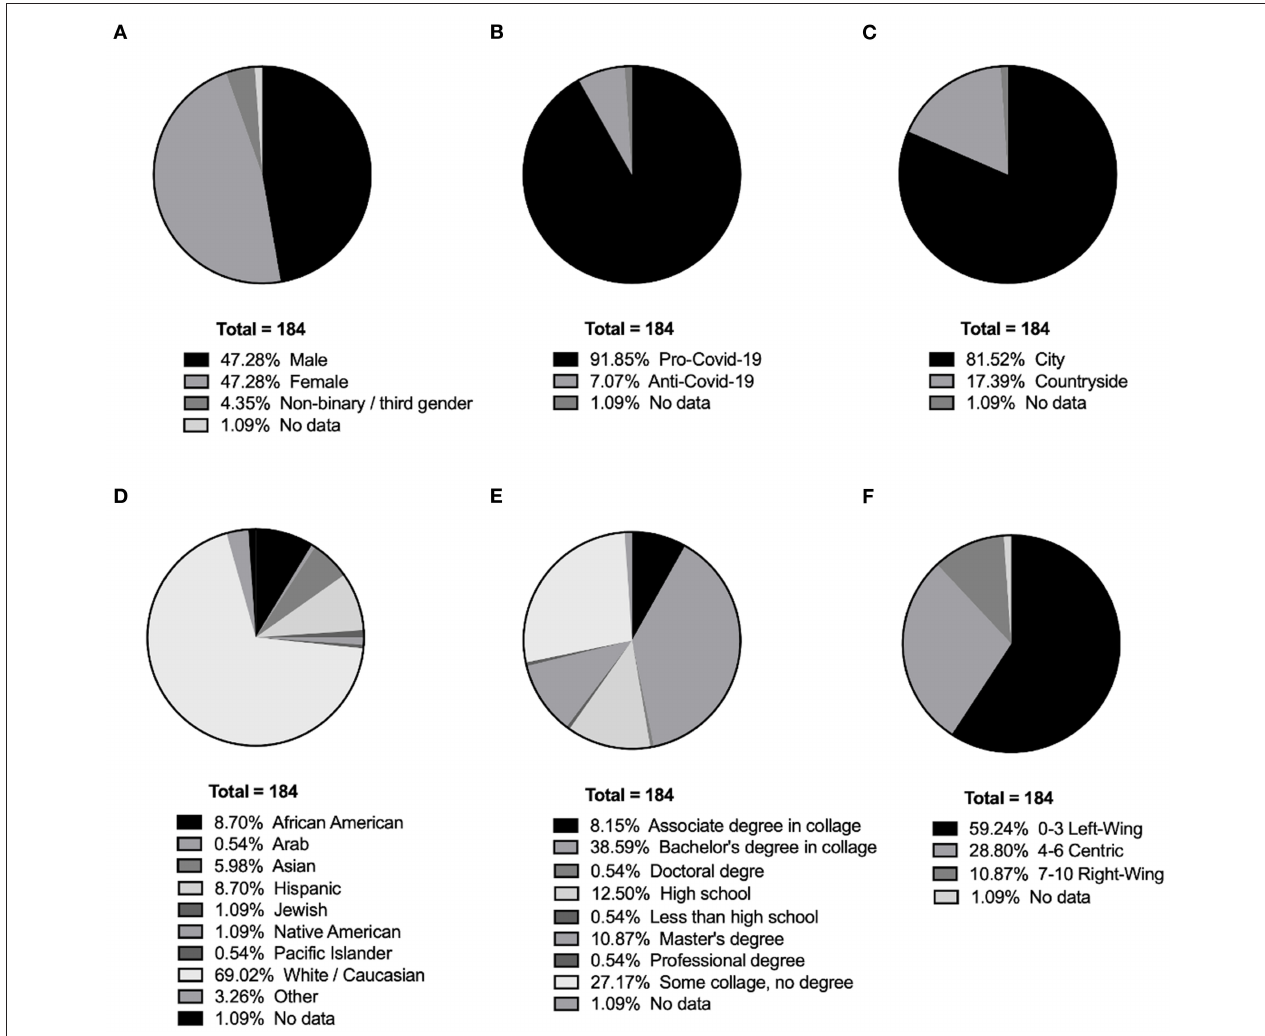
FIGURE 1 | The demographics of the studied sample: (A) gender; (B) COVID-19 attitude; (C) place of living; (D) ethnicity; (E) highest completed education; (F) cumulative political